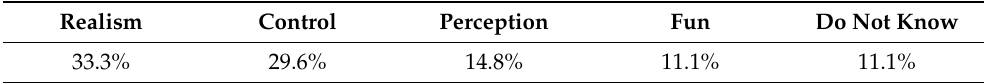
Table 8. Distribution of the reasons presented by the participants to the question “Why did you prefer to use real objects over paper cards?”